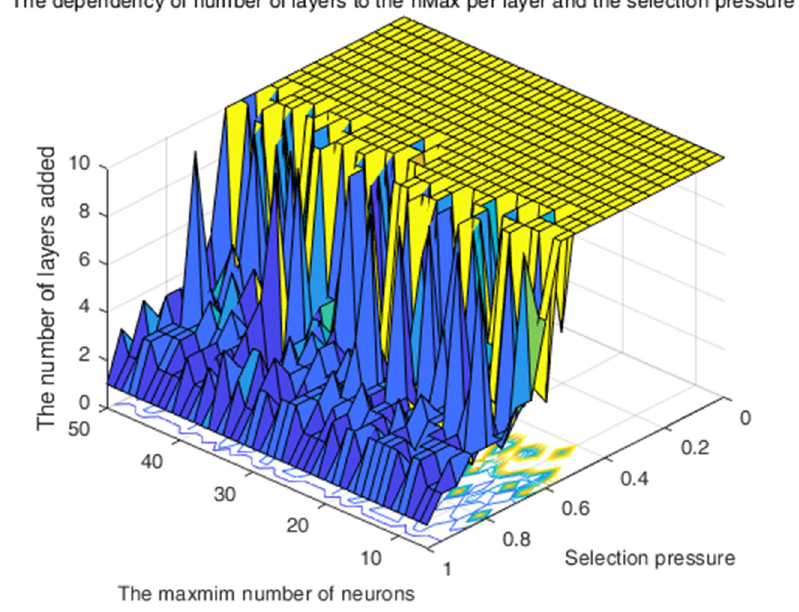
Figure 16. The dependency of the maximum number of layers added on the maximum number of neurons per layer and to the selection pressure coefficient.